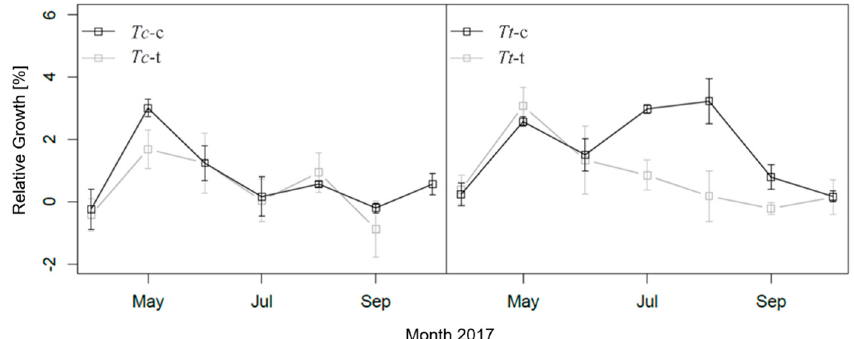
Figure 5. Monthly relative stem increment (%) of control and drought treatment groups of T. cordata and T. tomentosa from April to October 2017. Values denote the average of all trees per cultivar and group ± the standard deviation.